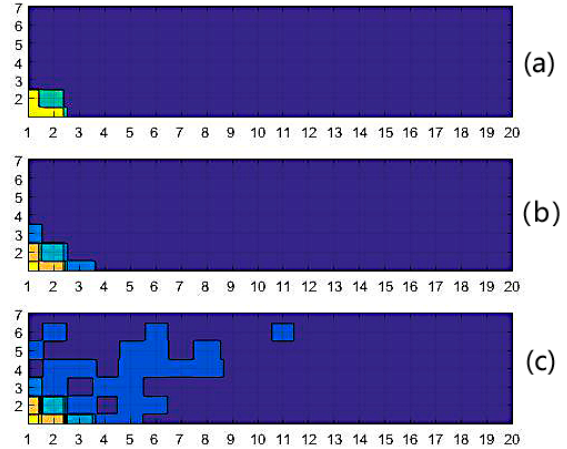
Figure 5. Pattern neurons partitioned with different steps (labels on the x axis and y axis are indices of RPs). ( a ) Existing thre categories when Δ = 0.4; ( b ) existing five categories when Δ = 0.2; ( c ) existing six categories when Δ = 0.1.